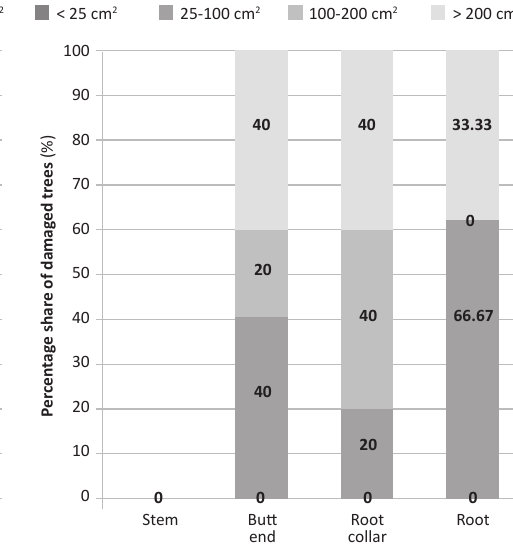
FIgURe 7. The distribution of different size damages depen- ding on the type of damage.